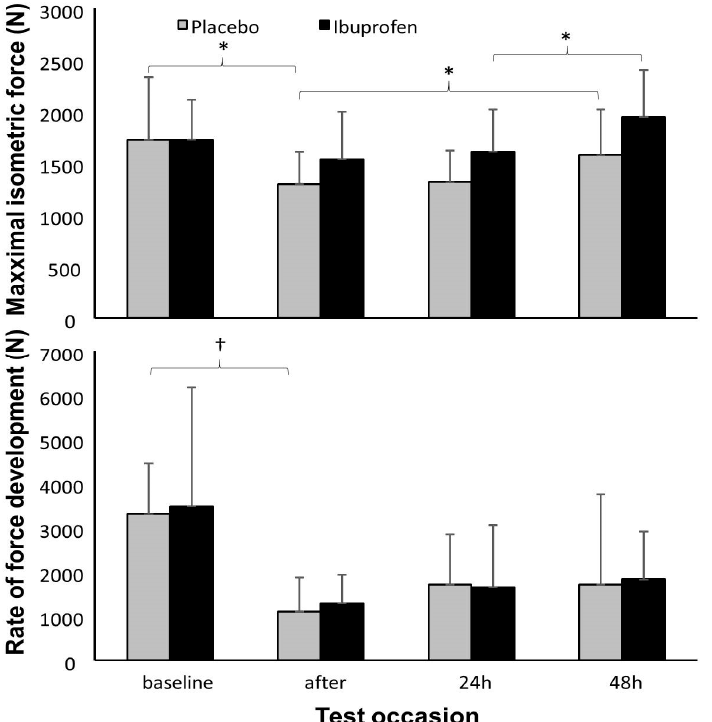
Figure 1. Mean ( ± SD) maximal isometric force and rate of force development before, straight after, post-24 h and post-48 h after a heavy bench press with a placebo vs. ibuprofen ingestion protocol. * = significant di ff erence between these two testing times for this condition ( p < 0.05); † = significant di ff erence between these two testing times for both conditions ( p < 0.05). Creatine kinase concentration levels increased significantly at 24 h after the exercise after which they decreased again. The concentration levels increased significantly 24 h post-exercise compared with baseline after placebo ingestion. Aspartate aminotransferase concentration levels increased immediately after the work out with the placebo protocol, while in the ibuprofen protocol it increased after 24 h. Alanine aminotransferase concentration levels increased directly after both ingestion protocols. However, after 48 h a significantly lower concentration level after the ibuprofen ingestion protocol was found compared with the placebo protocol (Figure 2).